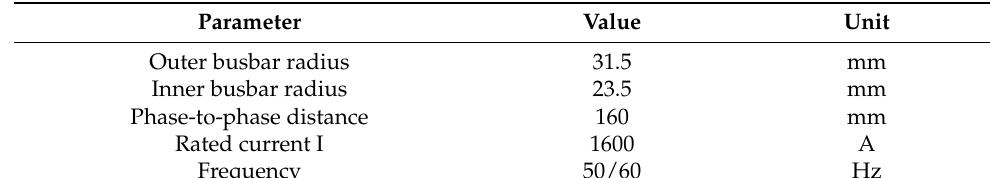
Table 8. Simulation properties for circular busbar system.